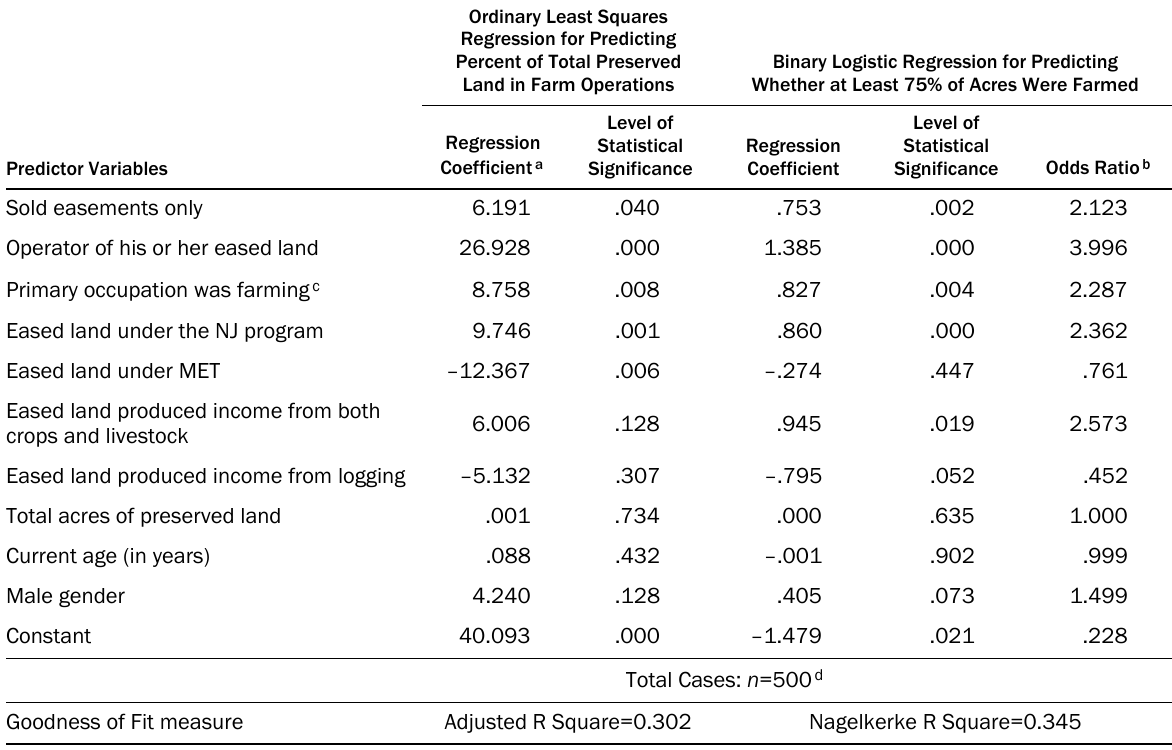
Table A1. Results of Ordinary Least Squares and Binary Logistic Regressions: Predictors of Percentage of Preserved Land Being in Owners’ and/or Their Tenants’ Farming